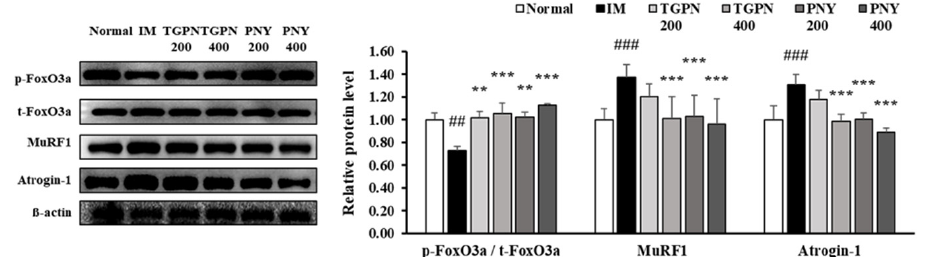
Figure 7. Effect of TGPN and PNY on muscle protein degradation mechanism in gastrocnemius muscle. Mice were subjected to hindlimb immobilization for one week, except for the normal group, and then administered with TGPN 200, 400 mg/kg, or PNY 200, 400 mg/kg for two weeks with continuous immobilization. Relative phosphorylation of FoxO3a, and relative protein levels of MuRF1 and Atrogin-1. The protein expression levels were normalized to the β -actin level. The data are expressed as mean ± SD. ## p < 0.01, ### p < 0.001 versus normal, ** p < 0.01, *** p < 0.001 versus IM.